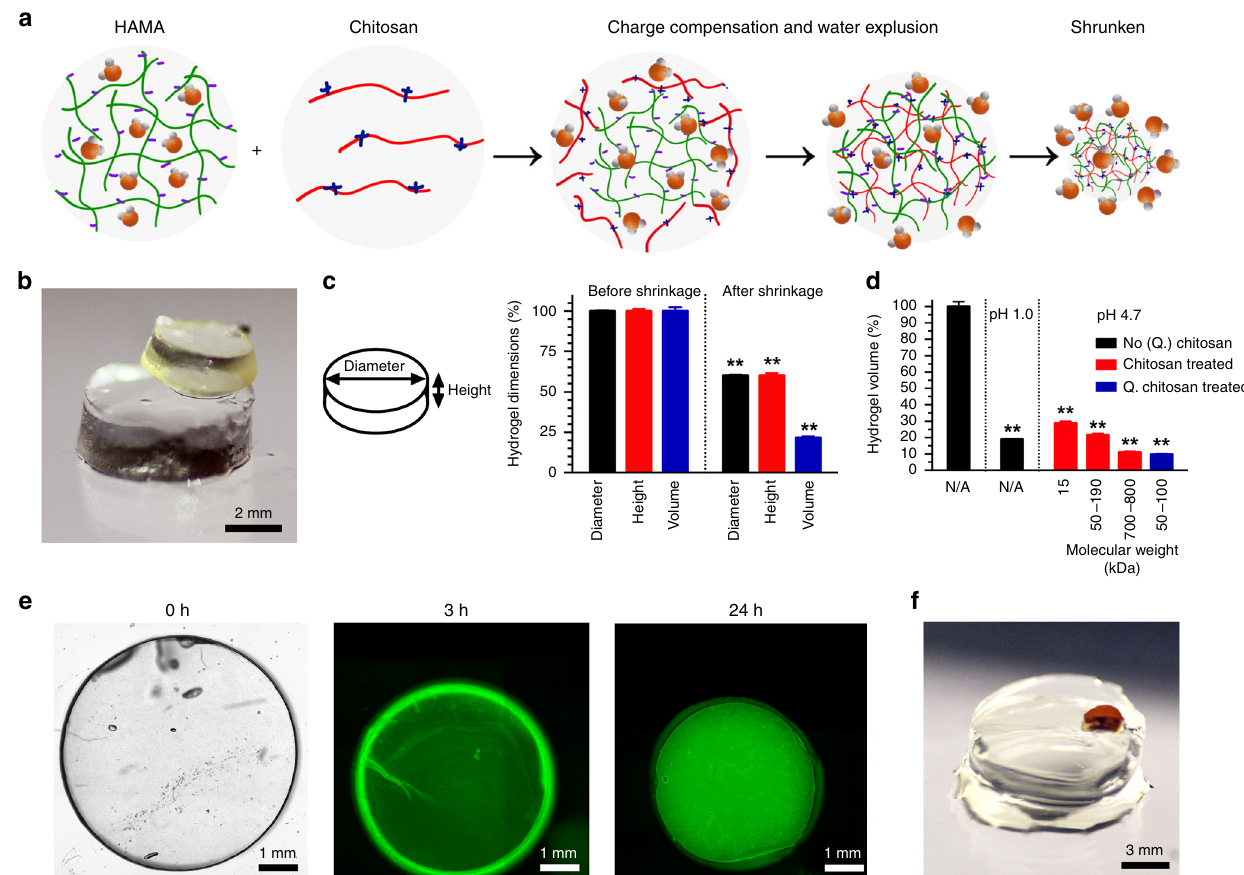
Fig. 1 The general mechanism of complexation-induced hydrogel shrinking. a Schematics showing the shrinking effect based on charge compensation. b Photograph showing size change of fabricated HAMA hydrogel (1.0 w/v%) before (lower) and after (upper) shrinking in 2.0 w/v% MM w chitosan dissolved in 1.0 v/v% acetic acid aqueous solution. c Schematic representation of a HAMA hydrogel disc together with the dimensions and corresponding quantitative analyses showing the dimensions and volume changes before and after shrinking in 2.0 w/v% MM w chitosan dissolved in 1.0 v/v% acetic acid aqueous solution. d Corresponding quantitative analyses showing the shrinking of HAMA hydrogels in perchloric acid solution (pH = 1.0) or in 1.0 v/v% acetic acid aqueous solutions (pH = 4.7) with 2.0 w/v% of chitosan of different molecular weights and types. e Confocal images showing the diffusion of the initial hydrogel. f Photograph showing size change of HM w chitosan hydrogels (2.0 w/v%), where the lower one was swollen in 1.0 v/v% acetic acid aqueous solution and the upper one was shrunken in 2.0 w/v% alginate in 1.0 v/v% acetic acid aqueous solution. ** P < 0.01; one-way ANOVA ( c , d , compared with the values of corresponding as-prepared samples); mean ± s.d, ( n =